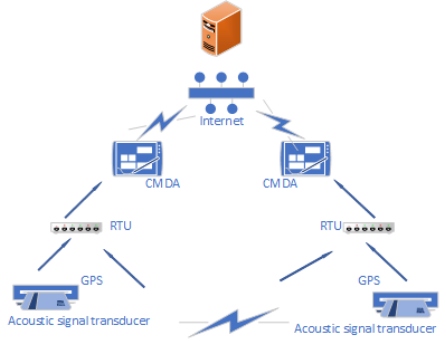
Figure 10. A Structure of Centralized WSN [9].